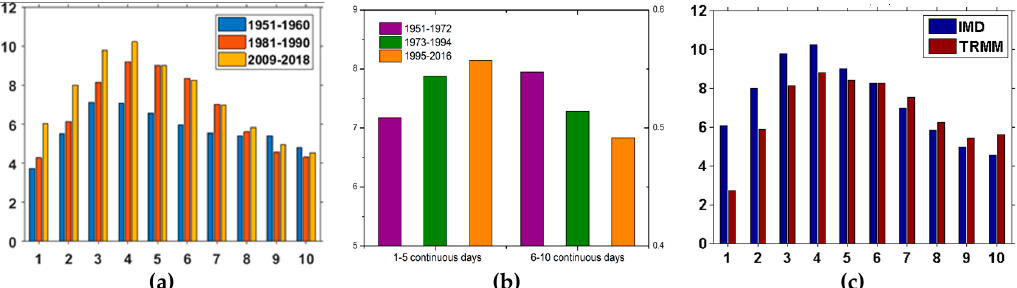
Figure 8. Rainfall contribution (in %) from the number of continuous rainfall days to the monsoon season over central India (a) IMD rainfall for 3 decades, (b) 1 to 5DAY and 6 to 10 DAY continuous combined days, (c) IMD rainfall vs. TRMM for the latest decade 2009-2018. Continuous rainfall of 1 day, 2 days, 3 days, 4 days and N days are referred as 1DAY, 2DAY, 3DAY and NDAY respectively.